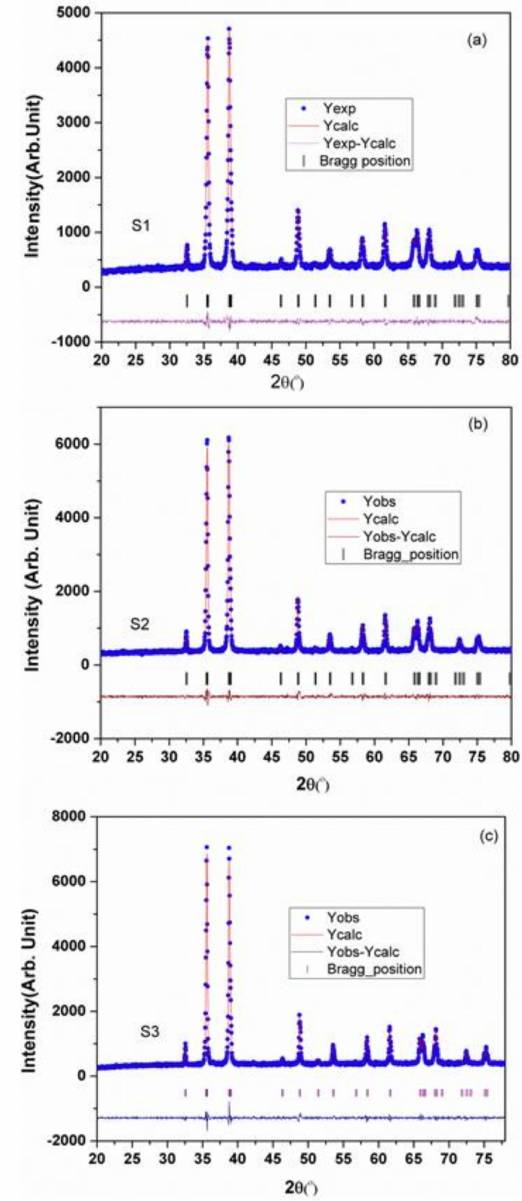
Figure 2. XRD patterns with Reitveld analysis for three di ff erent sized CuONPs: ( a ) S1 = CuONP–25 nm; ( b ) S2 = CuONP–50 nm; ( c ) S3 = CuONP–250